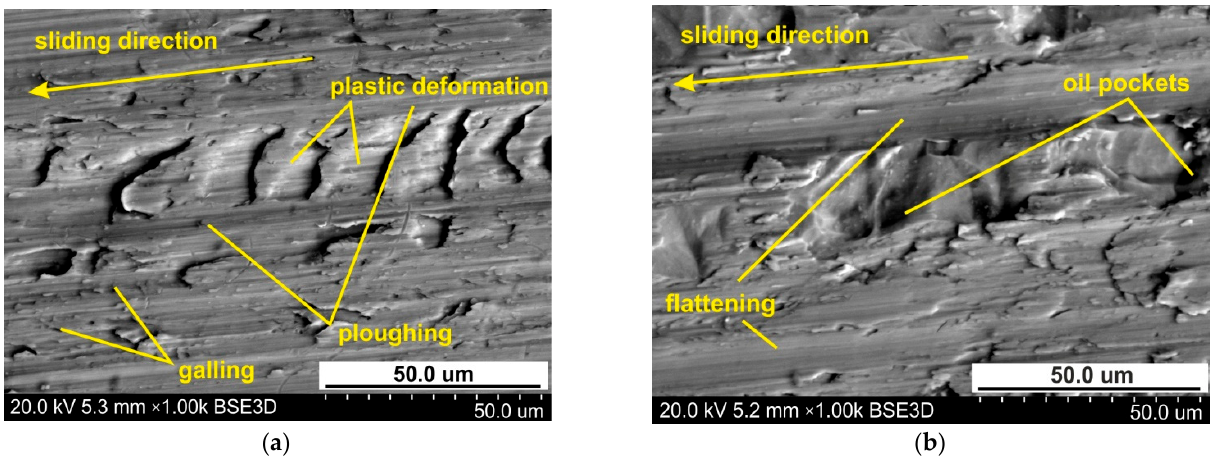
Figure 12. The specimen surfaces tested at 127 MPa in ( a ) dry friction and ( b ) lubricated conditions using engine oil SAE 10W-40.